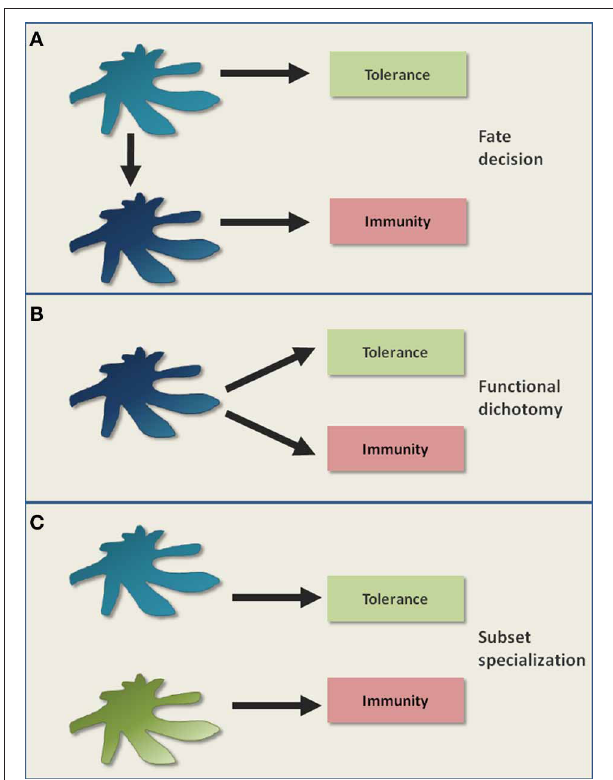
FIGURE 1 | Classical models of DC-mediated tolerance. It is a long standing controversy how DCs mediate immunological tolerance. (A) One classical view is that the maturation status of DCs acts as a switch, determining the decision for either tolerance in the steady state (immature/semimature DCs) or for immunity upon inflammation (mature DCs). (B) The subsequent discovery of immunosuppressive regulatory T cells that can be activated by both immature and mature DCs, raised the possibility for functional dichotomy. This means that a DC is capable of potentially executing both tolerogenic and immunogenic immune responses as parallel events. (C) Certain DC subsets were proposed to be inherently more potent in tolerance induction compared to other DC subsets. In this model, a division of labor between DC subsets regulates tolerance versus